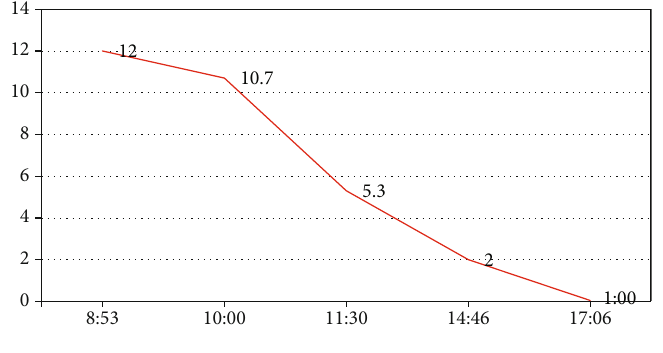
Figure 1: Serum lactate levels